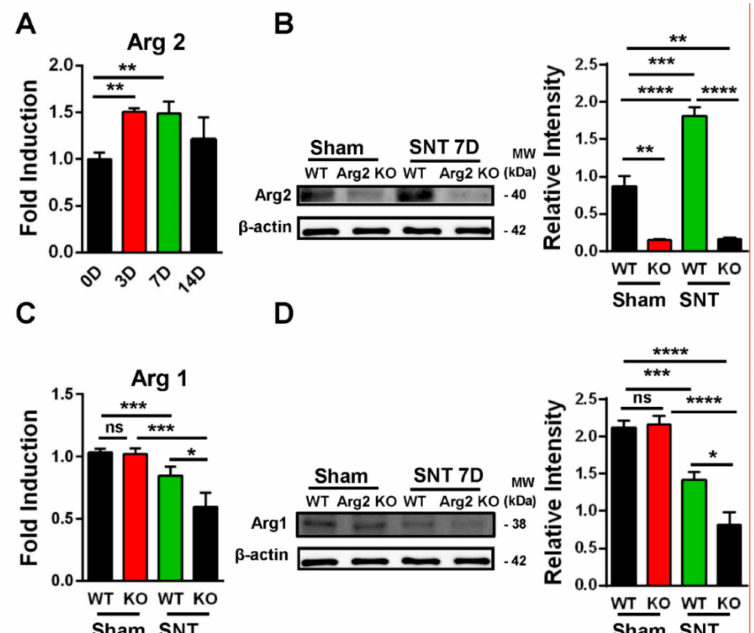
Figure 3. Upregulation of Arg2 in SNT WT mice and regulation of Arg1 after surgery. ( A ) The quantity of Arg2 mRNA increased in the spinal dorsal horn of WT mice on days 3, 7, and 14 post-surgery according to quantitative real-time polymerase chain reaction (qRT PCR) analysis. The maximum level was reached on day 3 and 7 post-surgery and was maintained until day 14. Data are presented as means ± SEM (one-way ANOVA with Tukey’s post hoc test, F (3,19) = 6.751, ** p < 0.01 versus 0D). ( B ) Representative western blots and corresponding quantitative data for band intensity, comparing the expression of Arg2 in the spinal dorsal horn of mice on day 7 from the sham WT ( n = 4), the sham Arg2 KO ( n = 4), the SNT WT ( n = 4), and the SNT Arg2 KO ( n = 4) mice. Arg2 was expressed more strongly in the SNT WT mice, compared to the sham WT mice. ( C ) The gene expression levels of Arg1 of the sham WT, SNT WT, sham Arg2 KO, and the SNT Arg2 KO mice on day 7. Data are presented as means ± SEM (one-way ANOVA with Tukey’s post hoc test, F (3,10) = 16.99, **** p < 0.0001, *** p < 0.001, * p < 0.05 versus WT or Sham). ( D ) The protein expression of Arg1 in the spinal dorsal horns of mice from the four groups ( n = 4 per group) on day